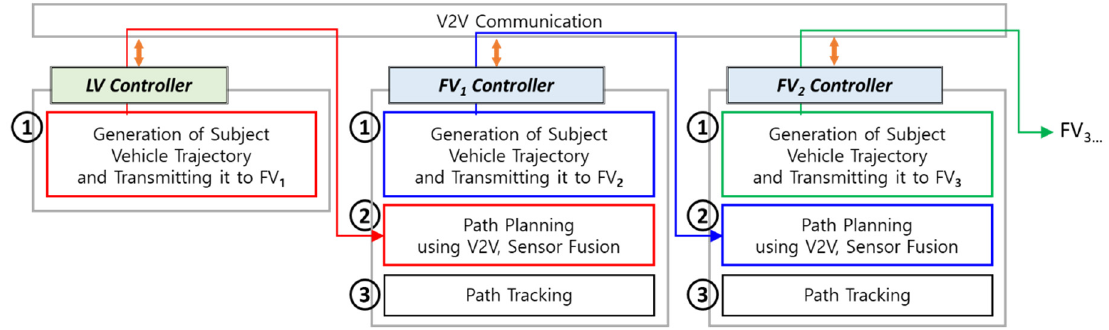
Figure 6. Overall architecture of truck platooning lateral controller.